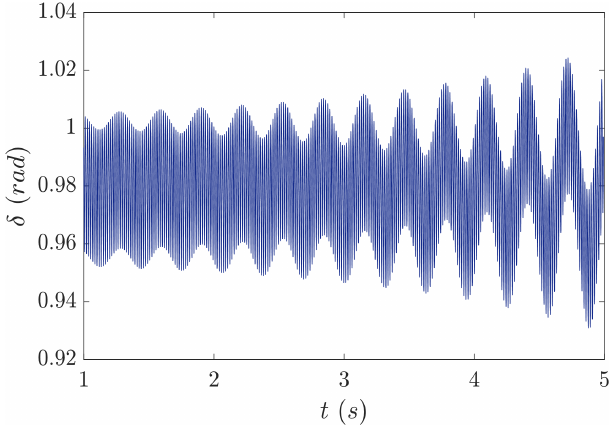
Figure 6. Bounded oscillations with two frequencies due to the torus bifurcation in D q = 390.